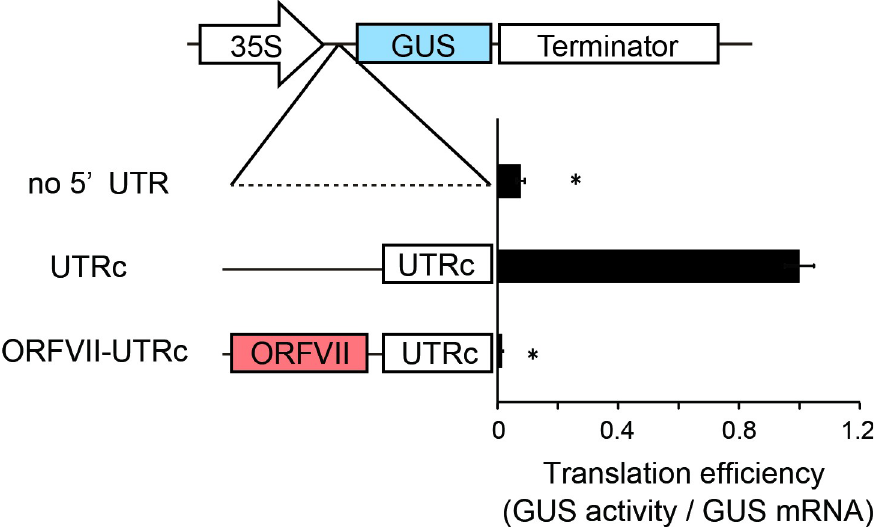
Fig 3. Examination of the IRES function in UTRc. "no UTR" and "UTRc" indicate 35S–GUS and UTRc–GUS, respectively. "ORFVII-UTRc" indicates the ORFVII–UTRc–GUS reporter that contains CaMV ORFVII upstream of the UTRc sequence. The results are expressed as the ratio of the enzymatic activity of GUS and the amount of corresponding GUS-containing mRNA synthesized in cultured rice cells, where the value of the GUS activity expressed from monocistronic mRNA is set as 1.0. GUS mRNA levels were estimated by real-time qRT–PCR. Error bars indicate the SD (n = 3). Asterisks indicate significant differences in the translational efficiency of UTRc at P < 0.05. The results shown represent the means obtained in three independent